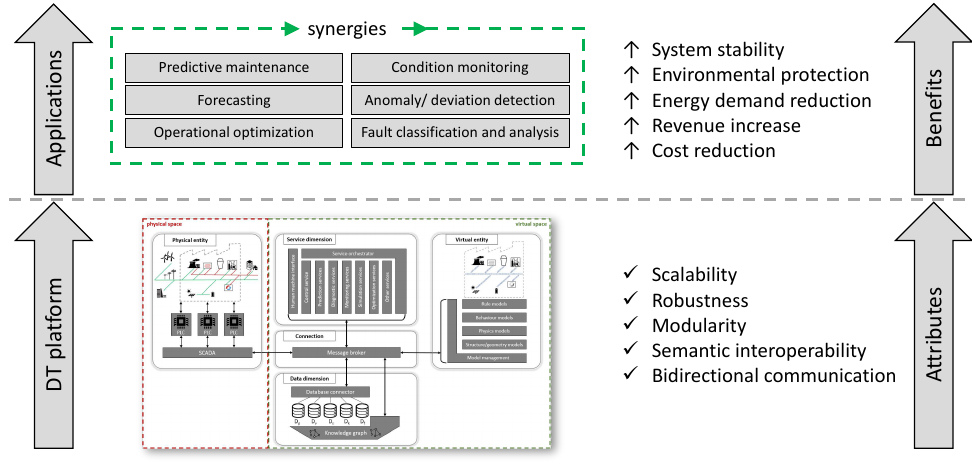
Figure 6. Illustration of DT platform benefits. By fulfilling IES-related requirements, hence realizing attributes such as scalability, robustness, modularity and semantic interoperability, the integration, operation and maintainability of applications as given in Table 1 are facilitated. These applications are leveraged, individually and by using synergies between them, to obtain benefits for the